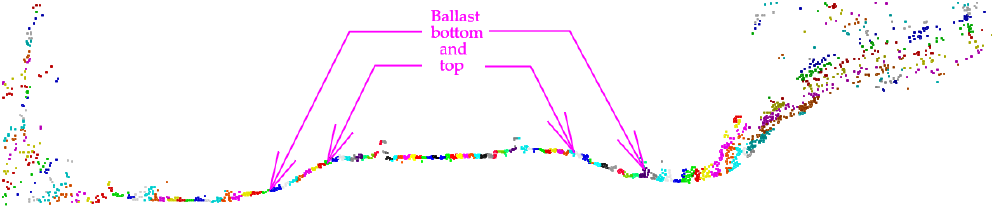
Figure 10. Scan angle coloured point cloud cross-section, with ballast top and bottom indication.